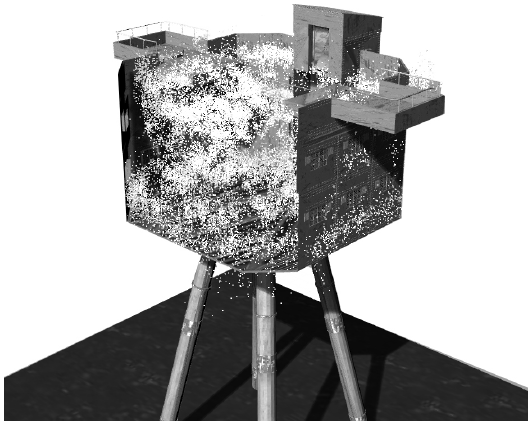
Figure 10. Point cloud data from the 3D scan arranged in a 3D model of a control tower of Maunsell Fort.